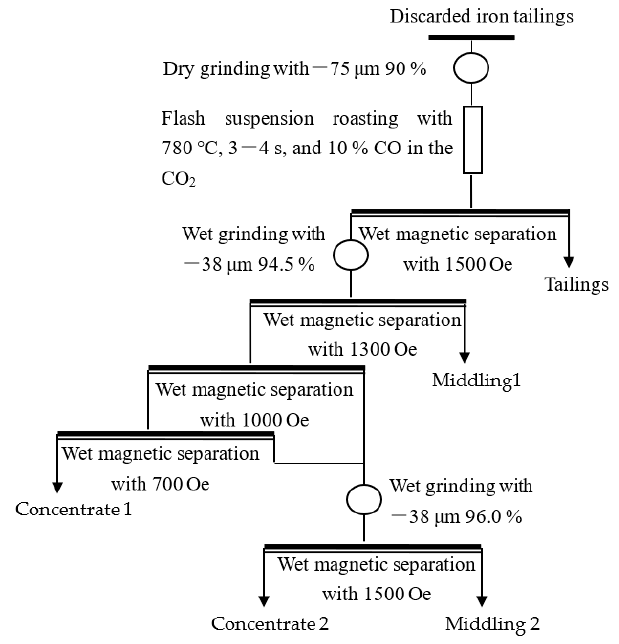
Figure 4. The flowchart of flash suspension roasting-magnetic separation.